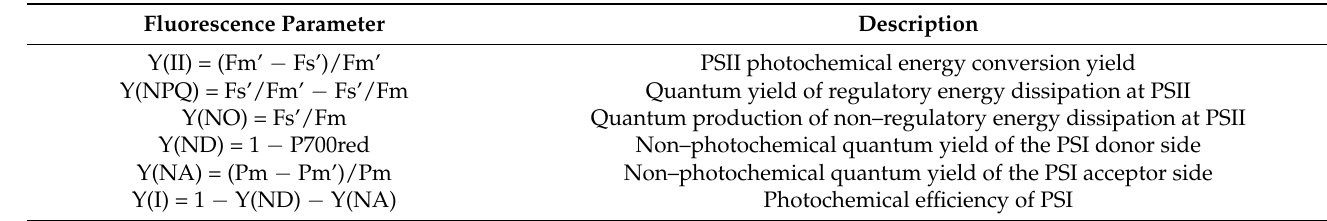
Table 2. Parameters related to energy conversion efficiencies in PSI and